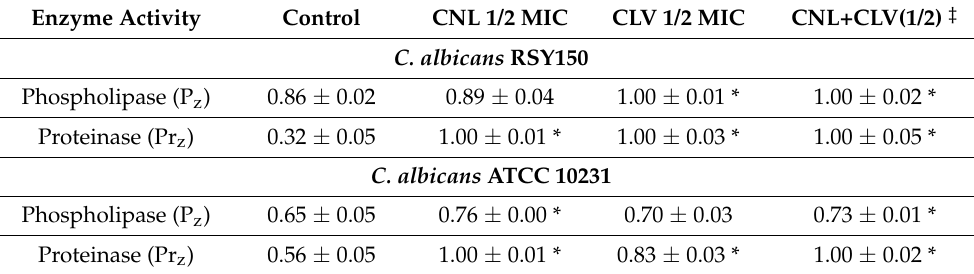
Table 3. Inhibition of C. albicans RSY150 and ATCC 10231 enzymatic activity by EOs.